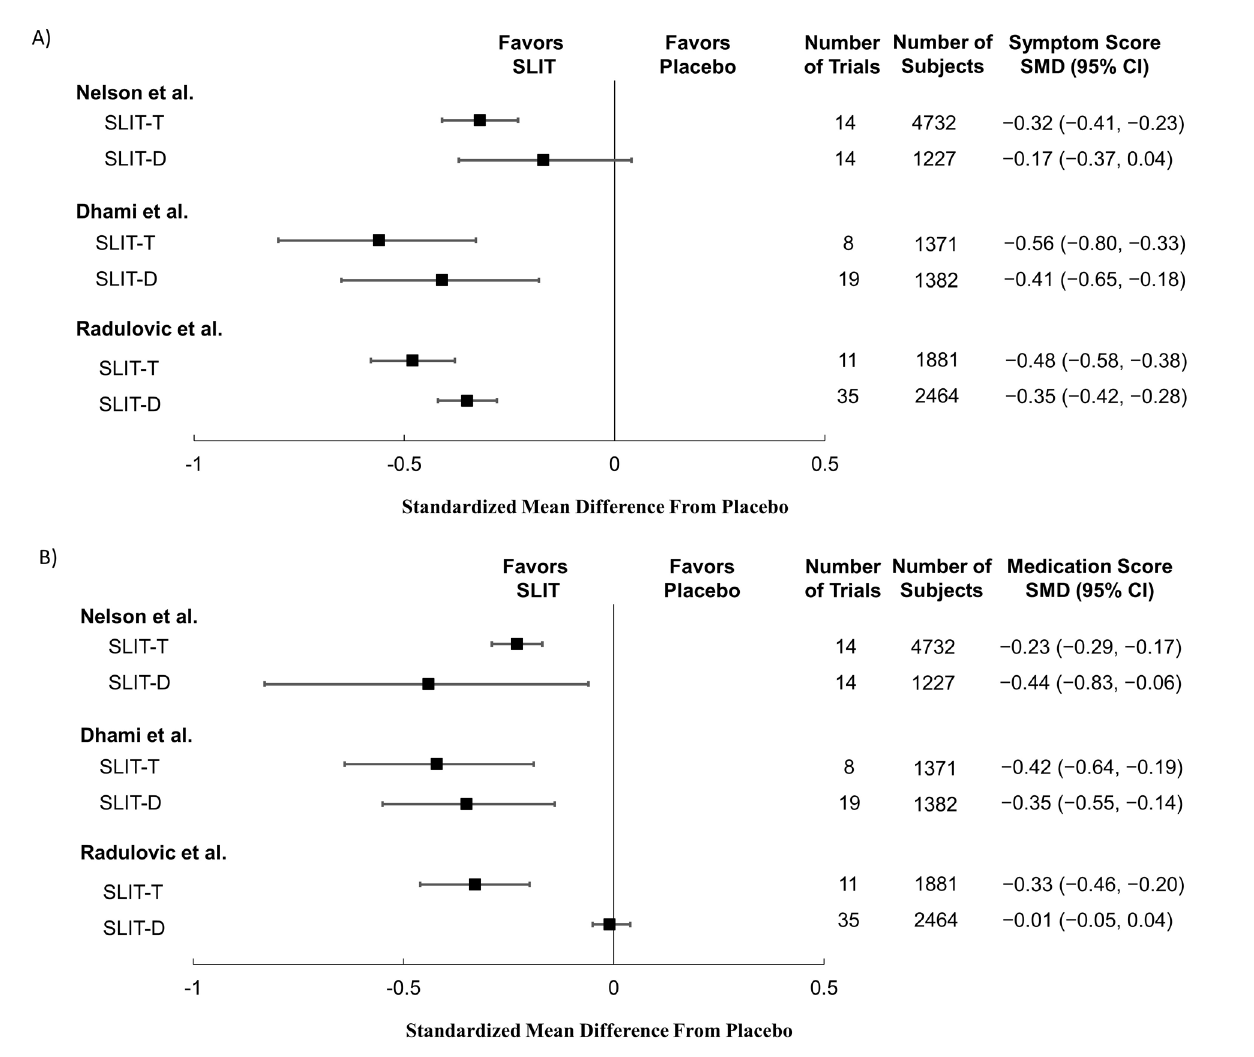
Figure 1. Comparison of the improvements versus placebo in A) symptoms and B) symptom-relieving medication use between SLIT-T and SLIT-D in published meta-analyses(63-65). SMD, standardized mean difference.